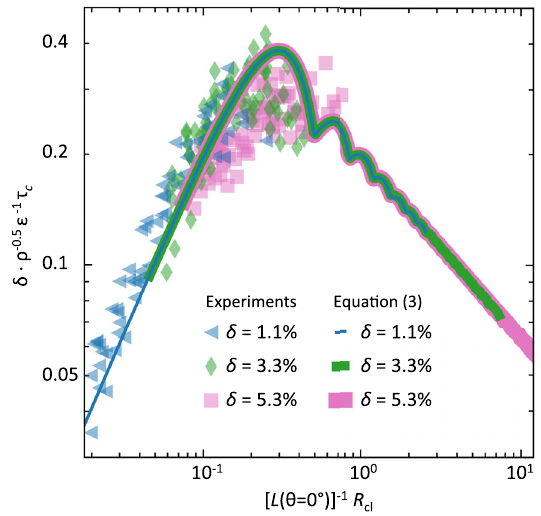
FIG. 7. Universal size scaling of critical torque. The same curves and experimental data points as in Fig. 2(c) of the main text, but expressed in terms of rescaled cluster size ½ L ð θ ¼ 0 ° Þ(cid:2) − 1 R and critical torque δ · ρ − 0 . 5 ϵ − 1 τ . Observe that the c cl theoretical curves, obtained following Eq. (3) of the main text, overlap perfectly, indicating a universal size dependence of the critical torque at any mismatched surface, i.e., for arbitrary δ > 0